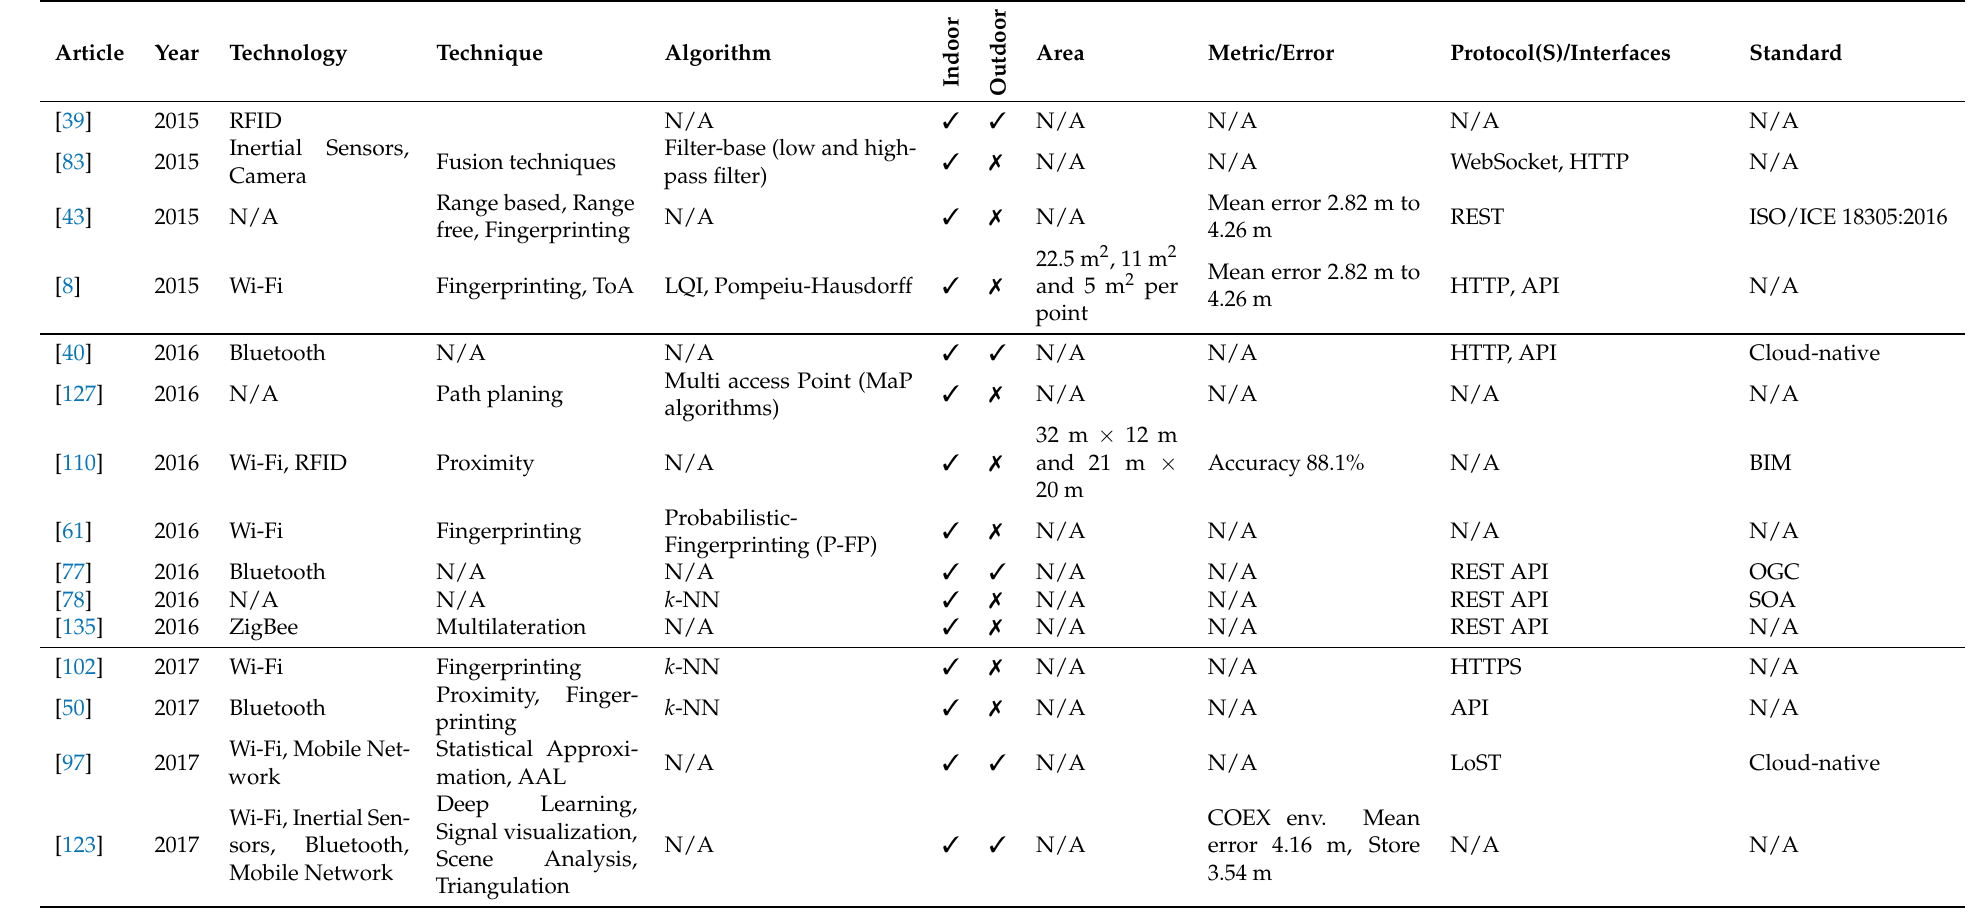
Table A1. Parameters analysed in the articles obtained from the systematic review